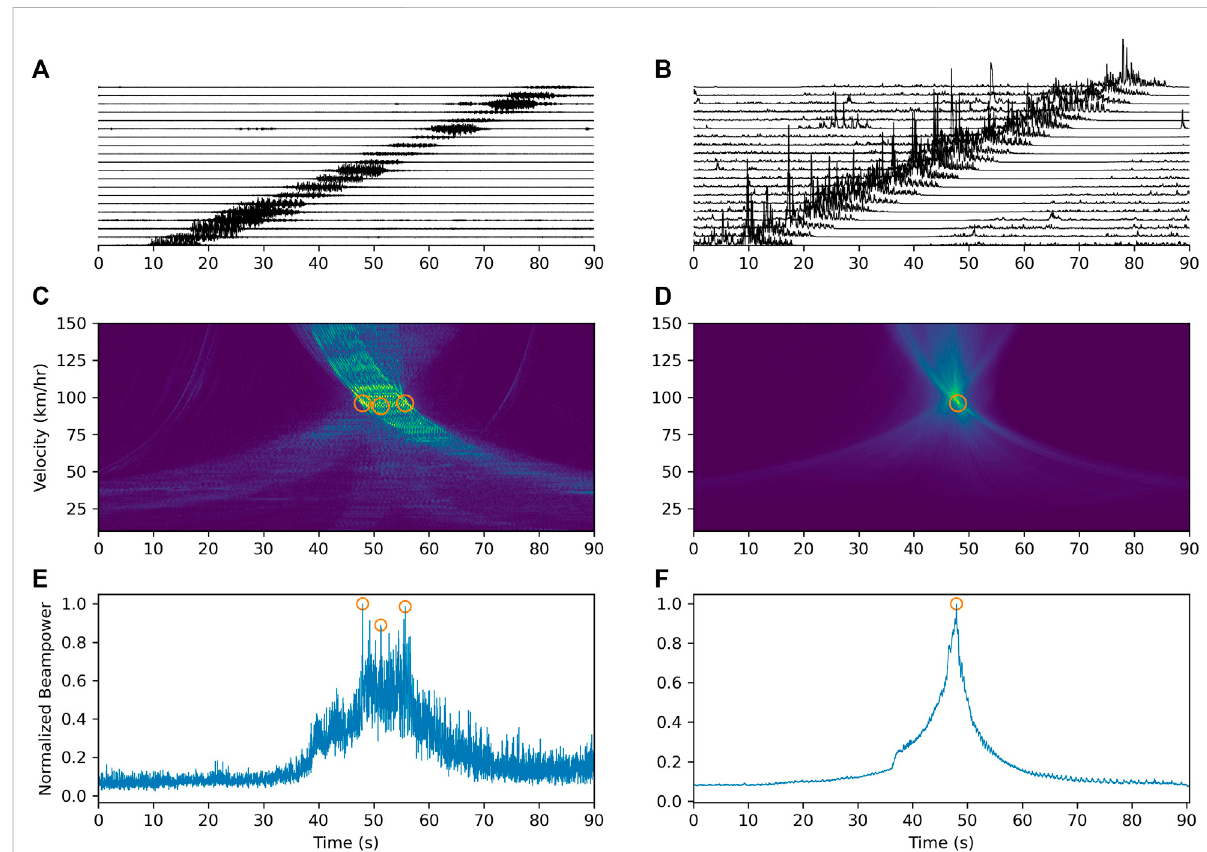
FIGURE 4 Comparison ofbeamformingresultsderivedfromrawsignalsandSTA/LTAtraces. (A) Signals extracted fromtheentirearrayevery50channels; (B) STA/LTA traces of the signals shown in (A) ; (C) Vespagram calculated with the whole-array raw data; (D) Same as (C) but derived from STA/LTA traces; (E,F) Time-beampower curves of (C,D)